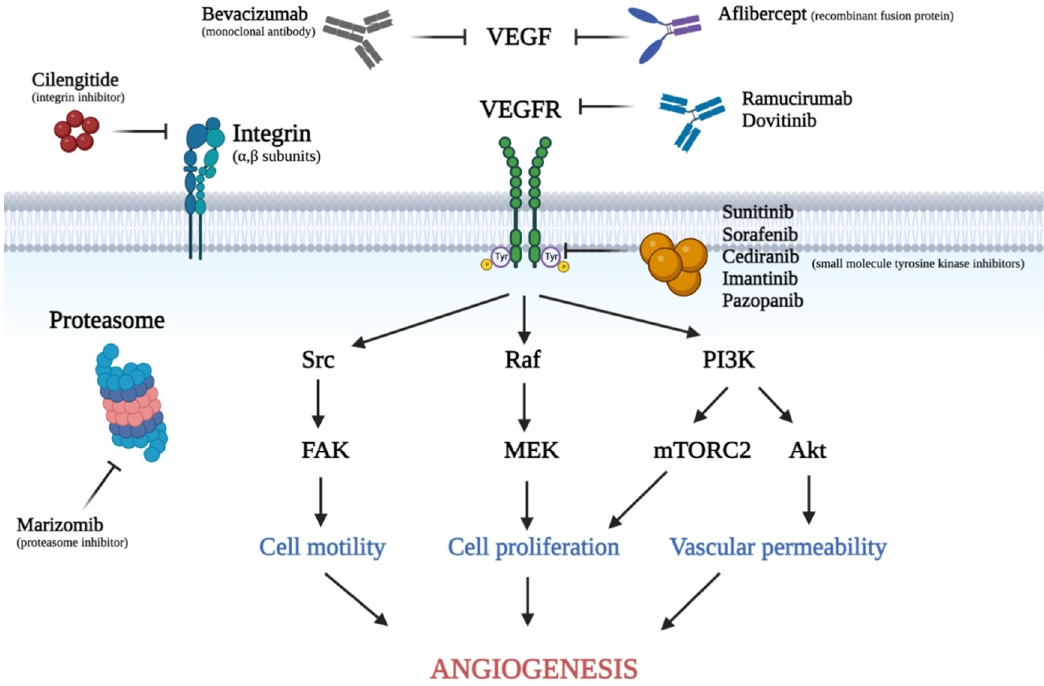
Figure 1. Visual demonstration of the VEGF signaling pathway and various anti-angiogenic agents discussed in this review. Soluble VEGF binds to its receptors located on the cell surface. This interaction leads to receptor dimerization and phosphorylation of tyrosine residues, activating the downstream signaling cascade such as Src, Raf, and PI3K. This eventually causes increased cell motility, cell proliferation, and vascular permeability. This figure was created with Biorender.com. VEGF: vascular endothelial growth factor, VEGFR: vascular endothelial growth factor receptor, PlGF: placental growth factor, TKI: tyrosine kinase